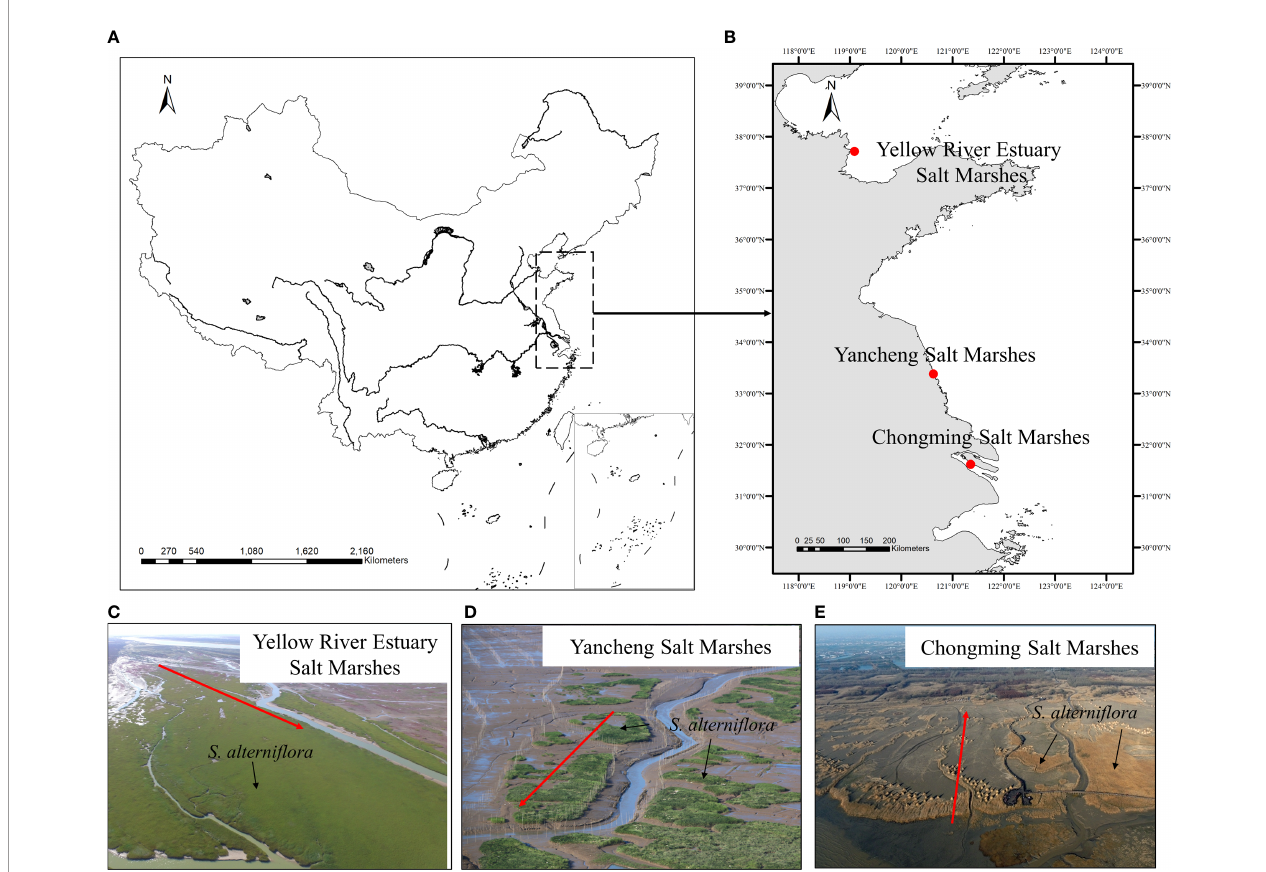
FIGURE 1 | Examples of Spartina alterni fl ora landward invasion along with tidal channel networks in China. (A) Map of China; (B) Locations of example invasion sites; (C) Yellow River Estuary Salt Marshes. Photo credit: Z.H. Ning and X. Ma; (D) Yancheng Salt Marshes (Source: http://img.itc.cn/photo/olbZcUsvYoA); (E) Chongming Salt marshes (Source: http://photocdn.sohu.com/20160107/Img433760555.jpg). The red arrow represents the direction of